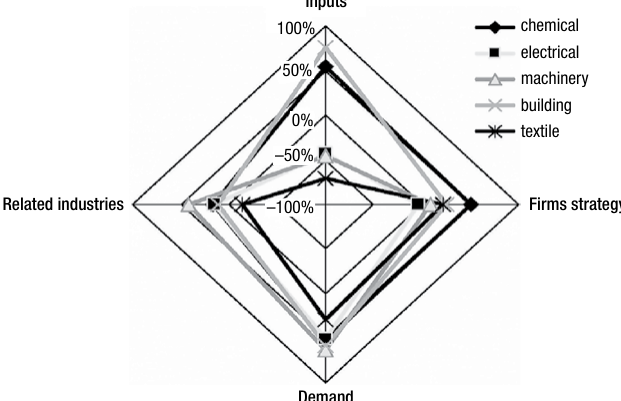
Fig. 3. The values of the determinants of competitive advantage for major industrial branches